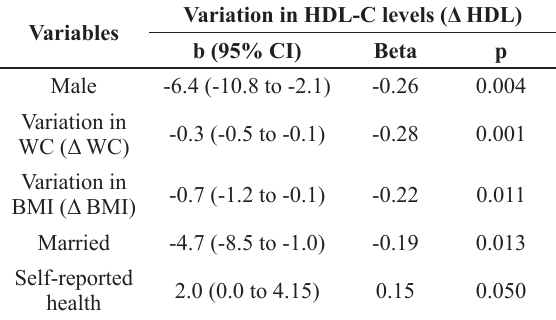
Multivariate linear regression analysis of factors associated with altered HDL-C